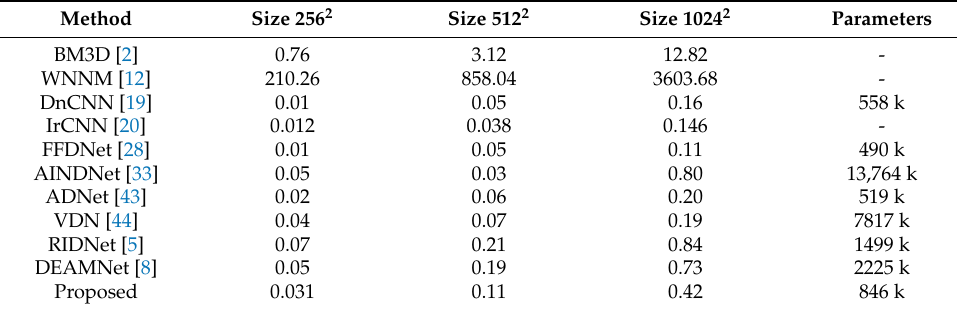
Table 3. Running time (in seconds) and parameter